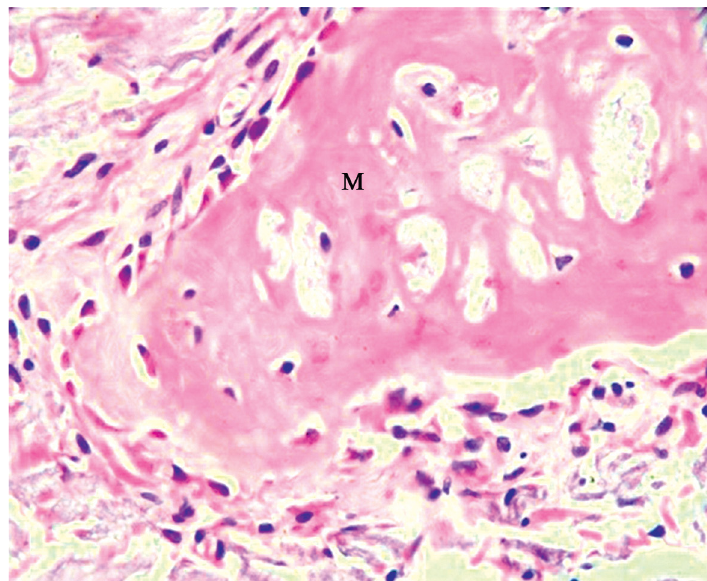
Figure 3- Group M: Membrane with bone formation inside it (M) (40x)